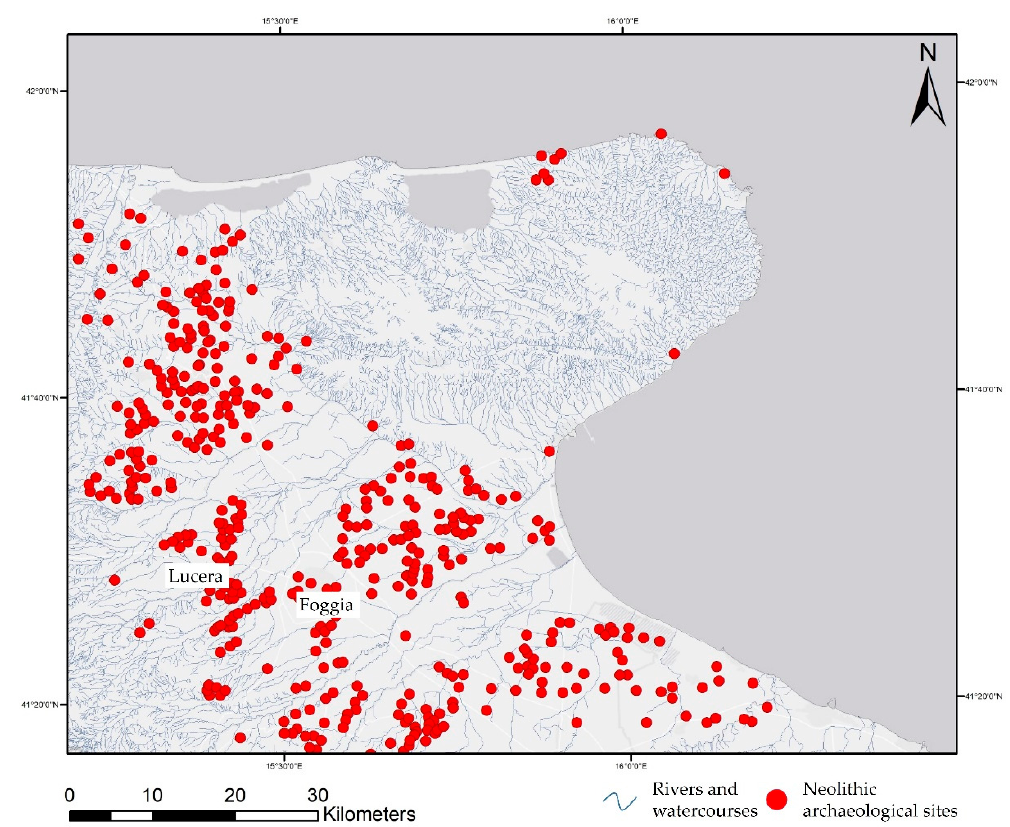
Figure 2. Map of the distribution of Neolithic settlements in the province of Foggia, reworked by the authors starting from different bibliographic sources and WebGis CartApulia [36,39,40].